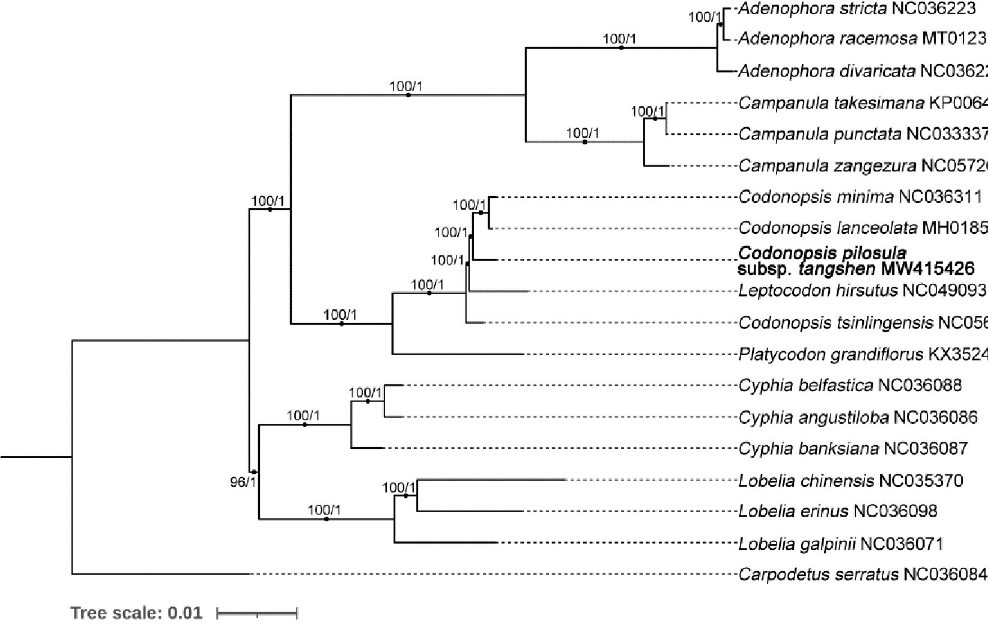
Fig 3. The phylogenetic tree of species from Codonopsis and other genus constructed based on the nucleotide sequences of 68 conserved plastid protein-coding genes using the maximum likelihood (ML) method and Bayesian Inference (BI) method. The number next to each node represents the corresponding bootstrap value and the BI posterior probabilities, respectively. The GenBank accession number are shown after the Latin name of the species. The sequence obtained from this study was highlighted in Bold. The length of the branch corresponds to the frequency of base substitutions.